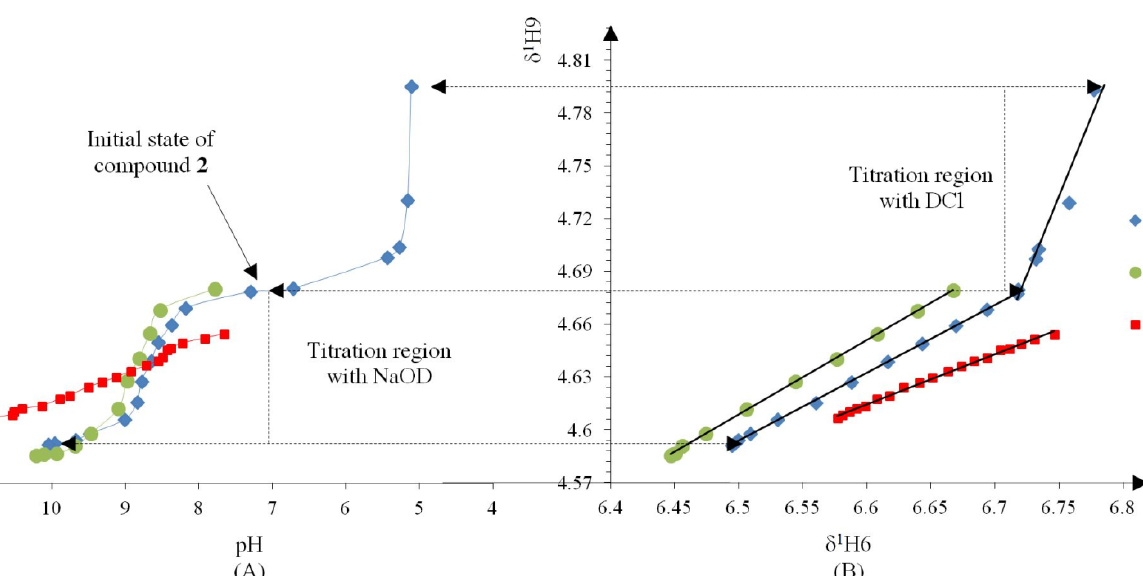
values with the Henderson- a vs. δ 1 of compounds 2 – 4 ; the initial data H6 H9